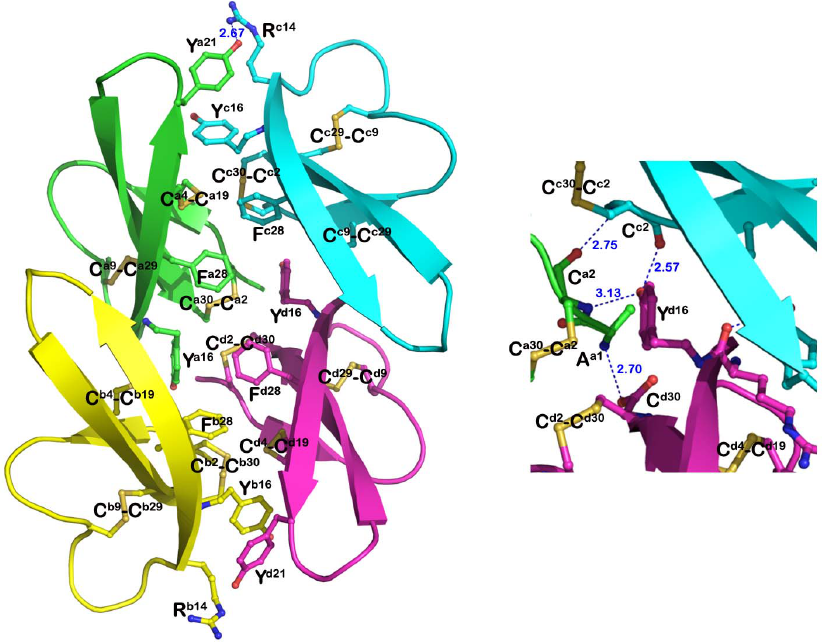
Figure 3. I20A/L25A-HNP1 mutant tetramer. The tetramer is stabilized by intensive hydrophobic interactions contributed mainly by the side chain atoms of Phe 28 and Tyr 21 and Cys 4 –Cys 19 and Cys 2 –Cys 30 The close-up view shows one of two hydrogen bond networks formed at the tetramer interface. The residues contributing to the tetramer formation are shown as balls and sticks. H-bond distances are given in Angstroms.